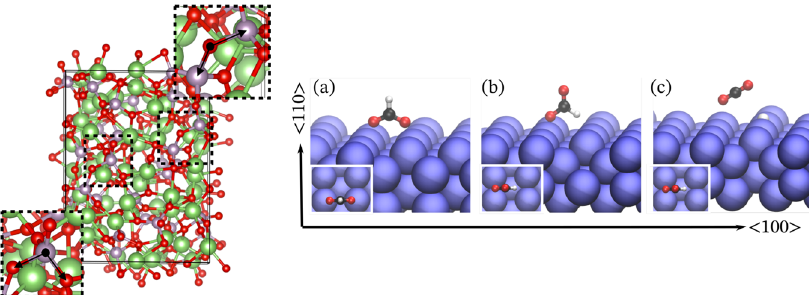
Fig. 2 Benchmark systems. Left: Quenched glass structure of Li 4 P 2 O 7 , including the tetrahedral bond angle (bottom left) and the bridging angle between corner-sharing phosphate tetrahedra (top right). Right: The formate on Cu system. Perspective view of atomic con fi gurations of ( a ) bidentate HCOO ( b ) monodentate HCOO and ( c ) CO 2 and a hydrogen adatom on a Cu(110) surface. The blue, red, black, and white spheres represent Cu, O, C, and H atoms, respectively. The subset shown in each subplot is the corresponding top view along the